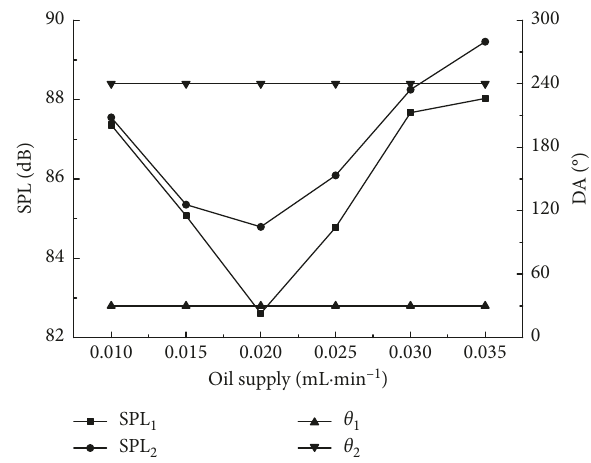
Figure 6: Variation trends of DAs and their SPLs with oil supply.